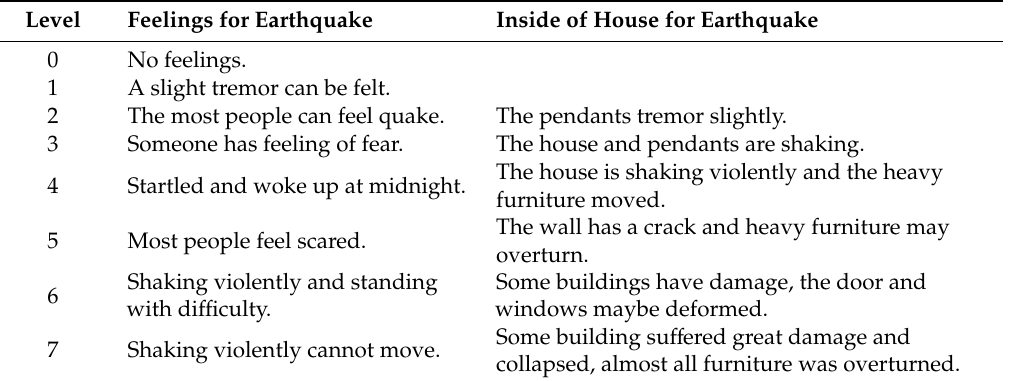
Table 1. Seismic scale level table from the Central Weather